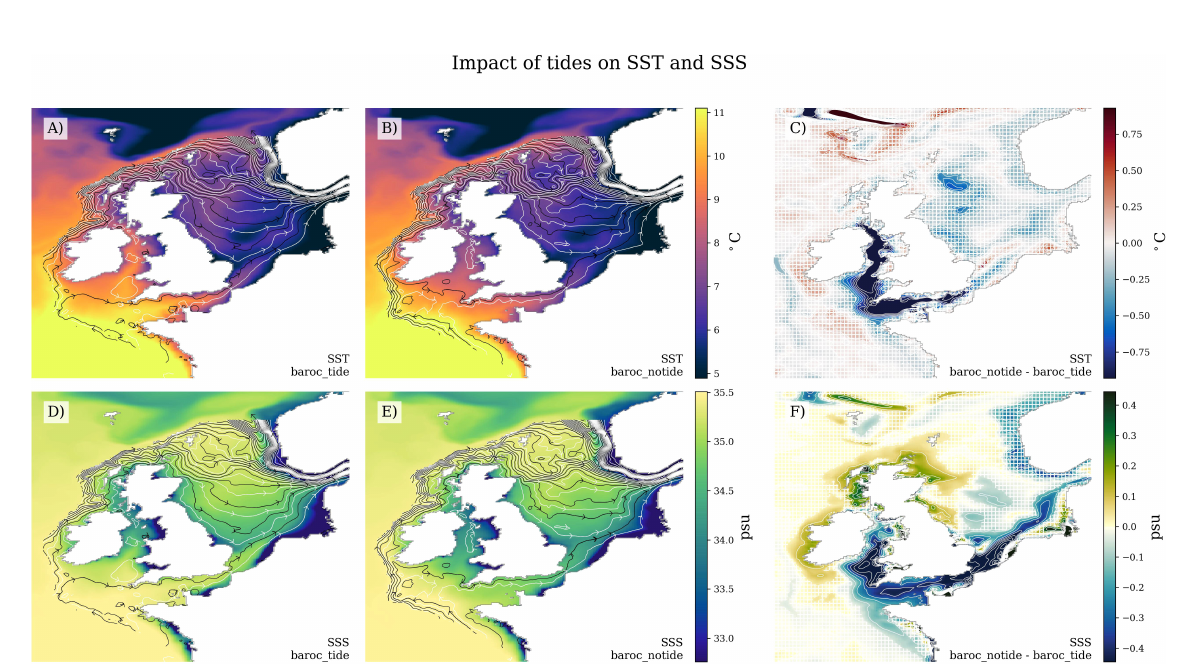
FIGURE 4 The impact of tides on the NWS winter mean SST and SSS. (A, B) , baroc_tide and baroc_notide mean SST with stream lines (from Figure 1). (C) Absolute difference between baroc_notide and baroc_tide with white hatching showing where the difference is not signi fi cantly different with a T-Test at the 5% level. (D – F) , equivalent to (A – C) but for